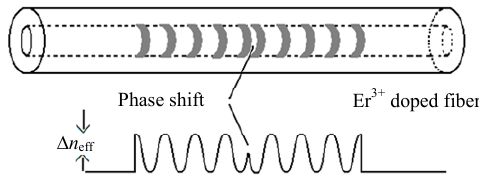
Fig. 1 DFB fiber laser